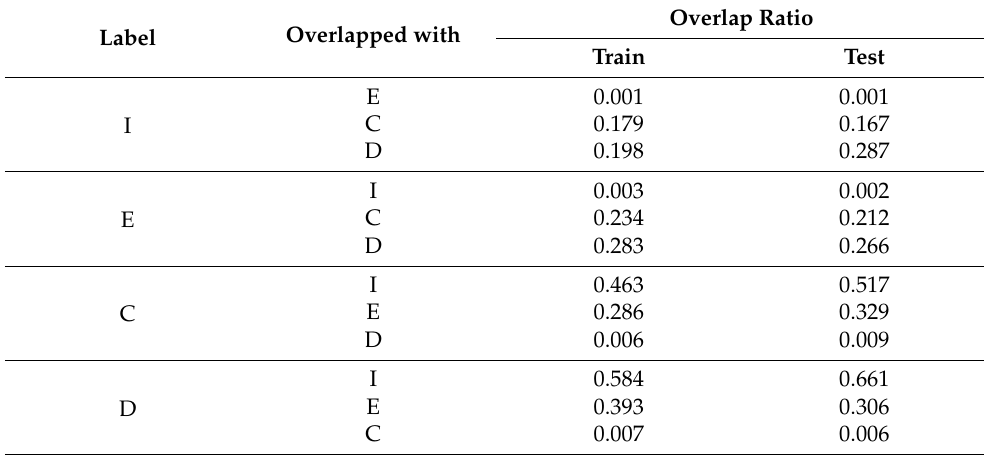
Table 5. Overlap ratios between I, E, C, and D labels in HF_Lung_V2.